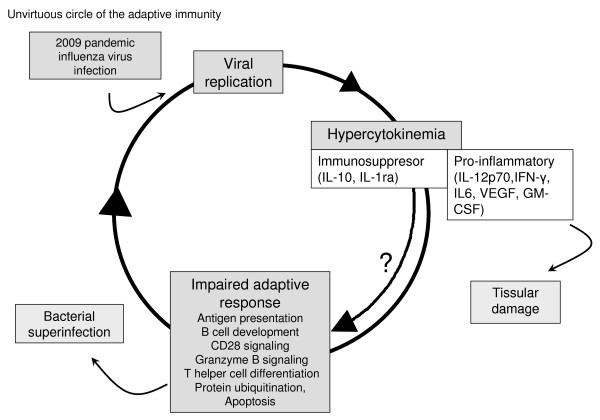
Host adaptive immunity deficiency (HAID) model in severe pandemic influenza. The picture shows the unvirtuous circle of the response to the virus.